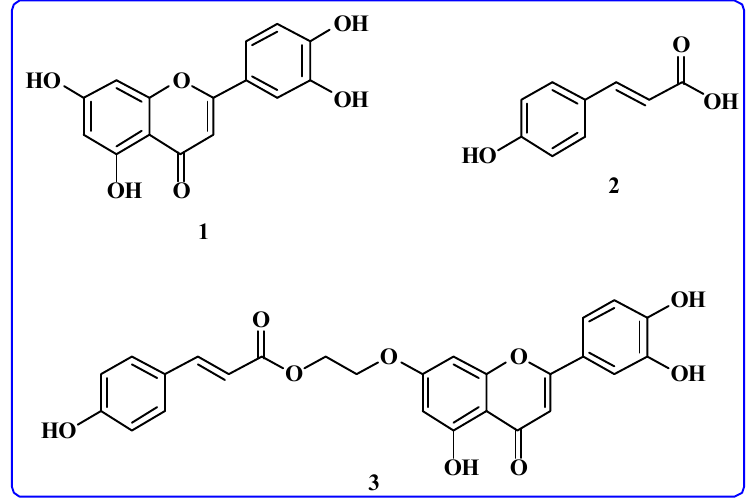
Figure 1. The structures of source compounds 1 , 2 , and 3 .